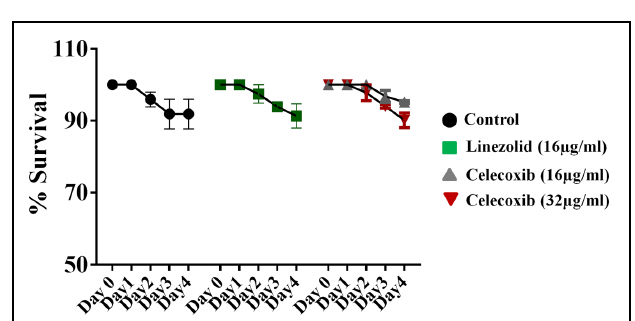
FIGURE 3 | Evaluation of toxicity in Caenorhabditis elegans model. C. elegans strain glp-4; sek-1 (L4-stage) were grown for four days in the presence of celecoxib (16 and 32 μ g/ml) and linezolid (16 μ g/ml). Worms were monitored daily and the live worms were counted. Results were expressed as percent live worms in relative to the untreated control groups. Triplicate wells were used for each group and the results were means ± SD ( n = 3).